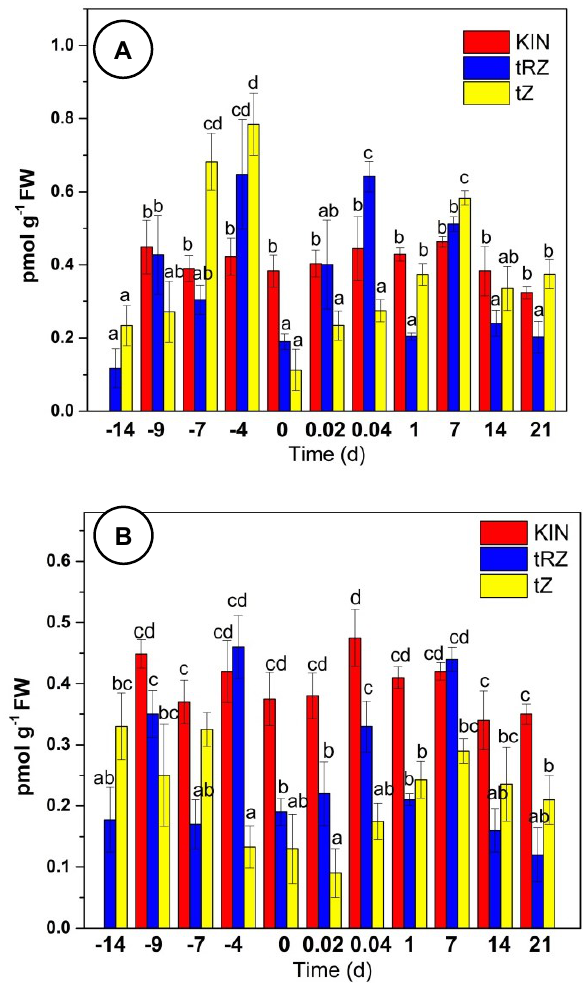
Figure 7. Endogenous CK content with CK inhibitor PVS. Preconditioning seedlings (-9, -7, -4, and 0 d) were supplemented with 0.5 µM ( A ); and 1 µM PVS ( B ). The chromatographic system is described in Materials and Methods. All the analyses were performed with three biological replicates. FW, fresh weight; error bars display standard error ( n = 3); KIN (red); tZ (yellow); and tZR (blue). Different letters represent the statistical significance of mean differences between each determination at a given time according to the Tukey test ( p <